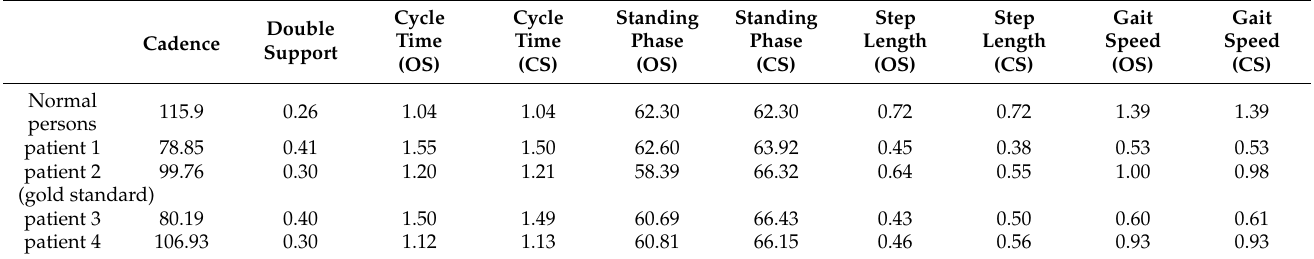
Table 1. Time–distance parameters; gold standard represents a sole knee